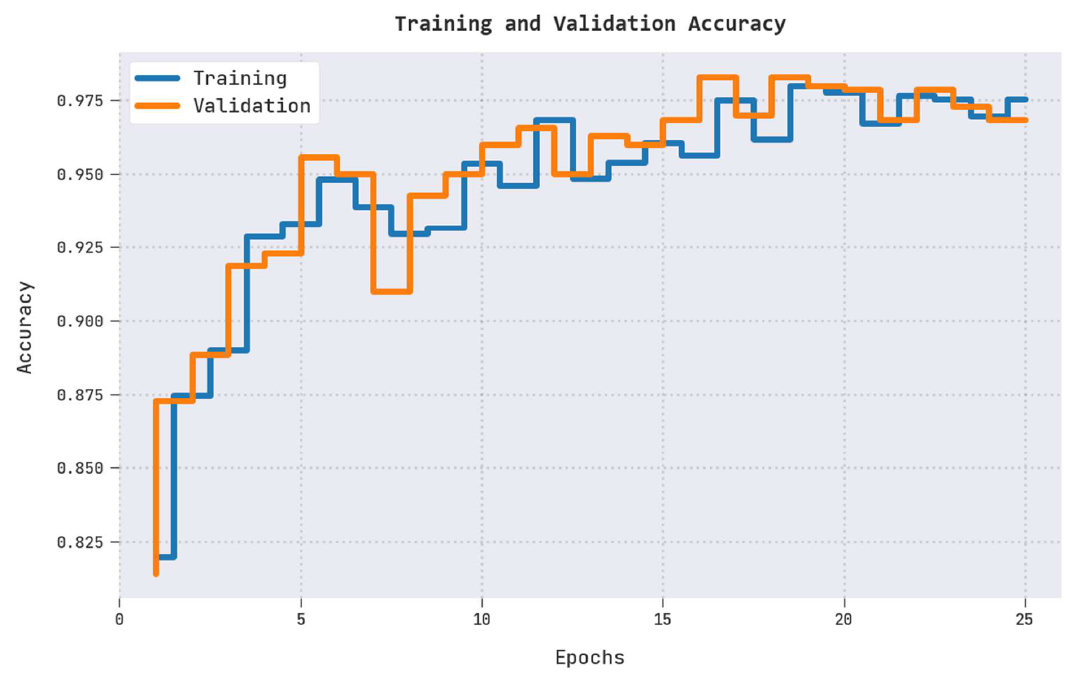
Figure 4. TRA and VLA analysis of the CL-DLBIDC approach. The training loss (TRL) and validation loss (VLL) obtained by the CL-DLBIDC method on the test dataset are exhibited in Figure 5. The experimental outcome repre- sented that the CL-DLBIDC algorithm has established minimal values of TRL and VLL. Particularly, the VLL is lesser than TRL.